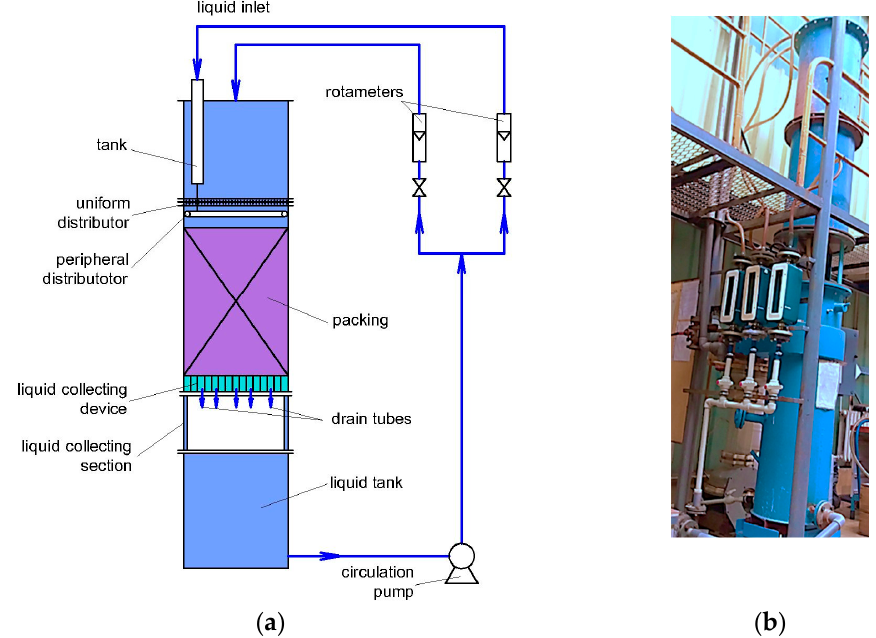
Figure 2. Semi-industrial packed column: ( a ) Scheme of the set-up; ( b ) Photography of the set-up. Two liquid distribution devices were combined to ensure two configurations of liquid distribution: (1) uniform liquid distribution over the cross-section surface of the column and (2) peripheral distribution only on the column wall, as shown in Figure 3.